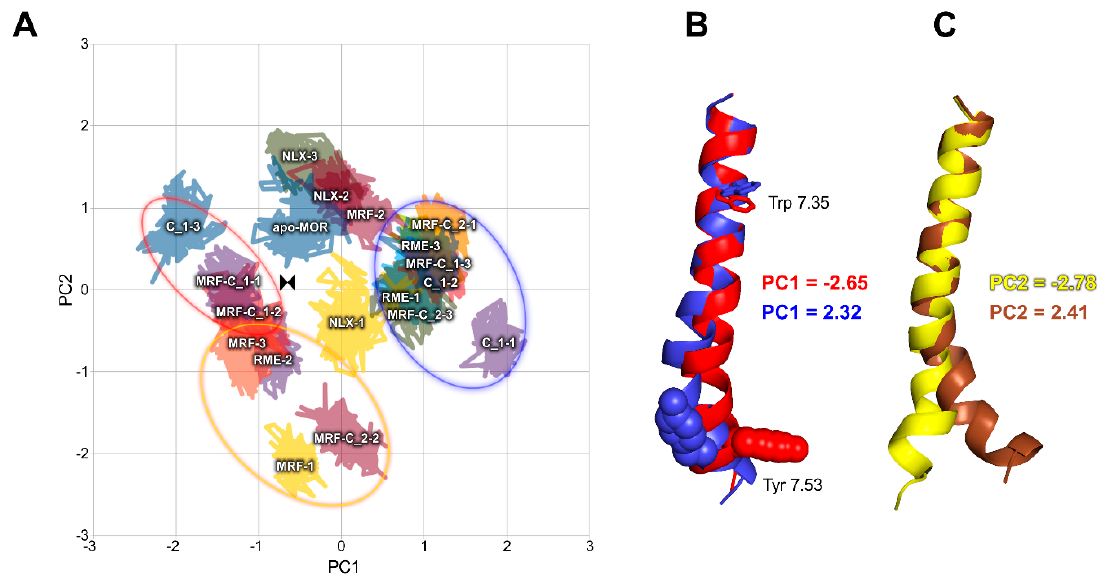
Figure 6. PCA of TM7. ( A ) Conformational space occupied by investigated complexes through last 50 ns of simulations in a common space. Ellipses were added to the graphs to facilitate referring to projections on trajectories. Color-coding of ellipses corresponds to the part B and C of the figure. ( B ) Projections of extreme PC1 values on trajectories, depicting main conformational di ff erences between groups presented in the part A of the figure. Color-coding of the legend corresponds to colors of the helices. ( C ) Projections of extreme PC2 values on trajectories, depicting main conformational di ff erences between groups presented in the part A of the figure. Color-coding of the legend corresponds to colors of the helices.